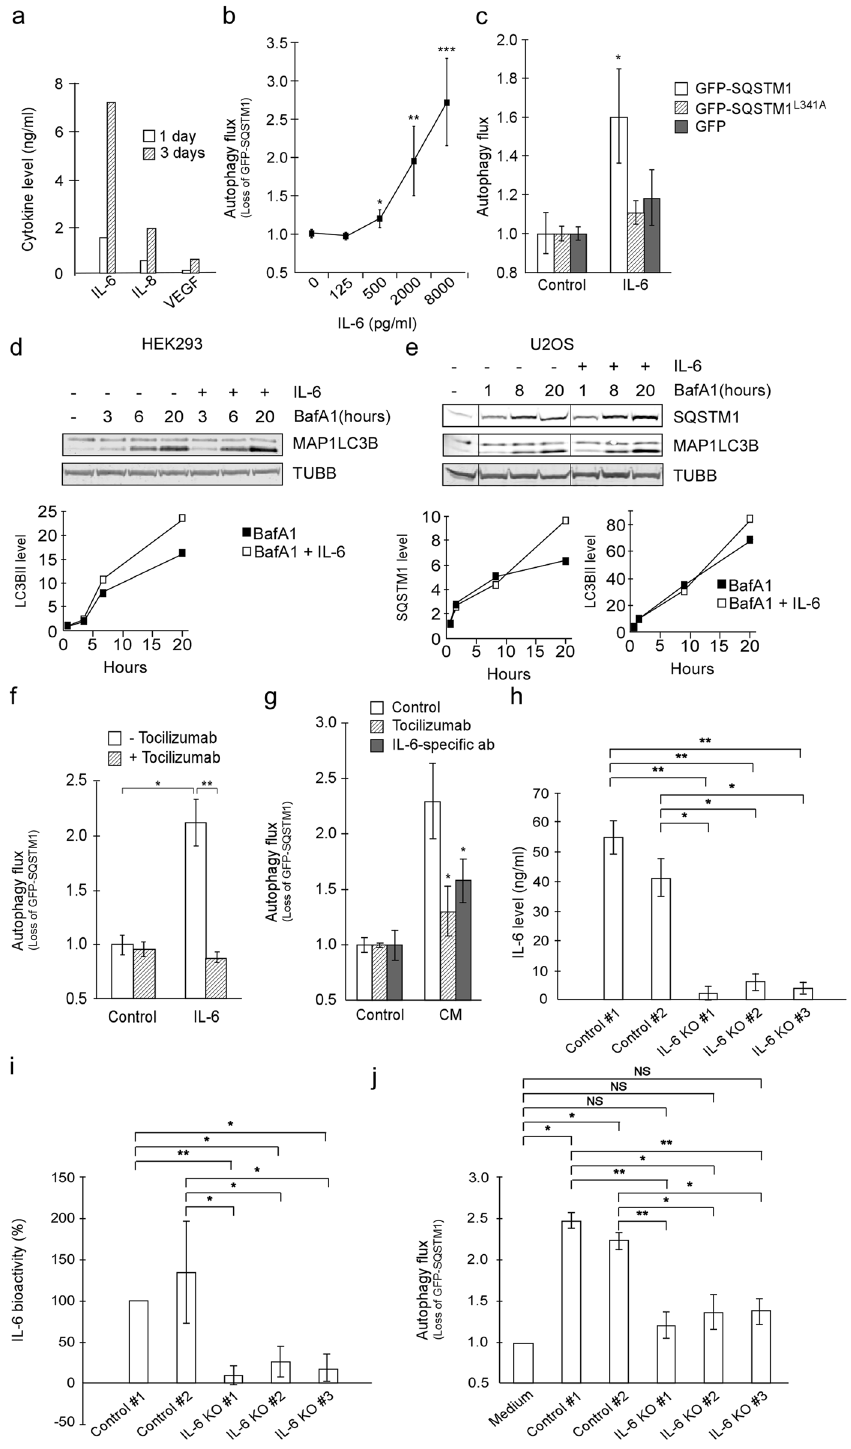
Figure 3. IL-6 secreted from TOV21G cells induces autophagy. ( a ) Bio-Plex assay of TOV21G conditioned medium (CM) (1 and 3 days cultivation). ( b ) Autophagy flux in reporter cells following 3 days of rIL-6 exposure. Mean from three independent experiments using duplicate wells ± SD. * p < 0.005, ** p < 1 × 10 − 4 , *** p < 5 × 10 − 6 vs control (Student t-test). ( c ) Degradation rate of GFP-SQSTM1, GFP and GFP-SQSTM1 L341A protein in HEK293 cells following rIL-6 (20 ng/ml) exposure. Mean from one representative of three independent experiments using triplicate wells ± SD. * P = 0.01 vs control (Student t-test). ( d ) MAP1LC3B protein levels in reporter cells treated with rIL-6 (20 ng/ml) and/or BafA1 (100 nM). MAP1LC3B-II signals normalized against β -tubulin/TUBB. Data representative for five independent experiments. ( e ) As D, but U2OS cells stained for both MAP1LC3B and SQSTM1. Data representative for two independent experiments. Image, originating from the same blot, is cropped. ( f ) Autophagy flux in reporter cells treated with rIL-6 (20 ng/ml) alone or in